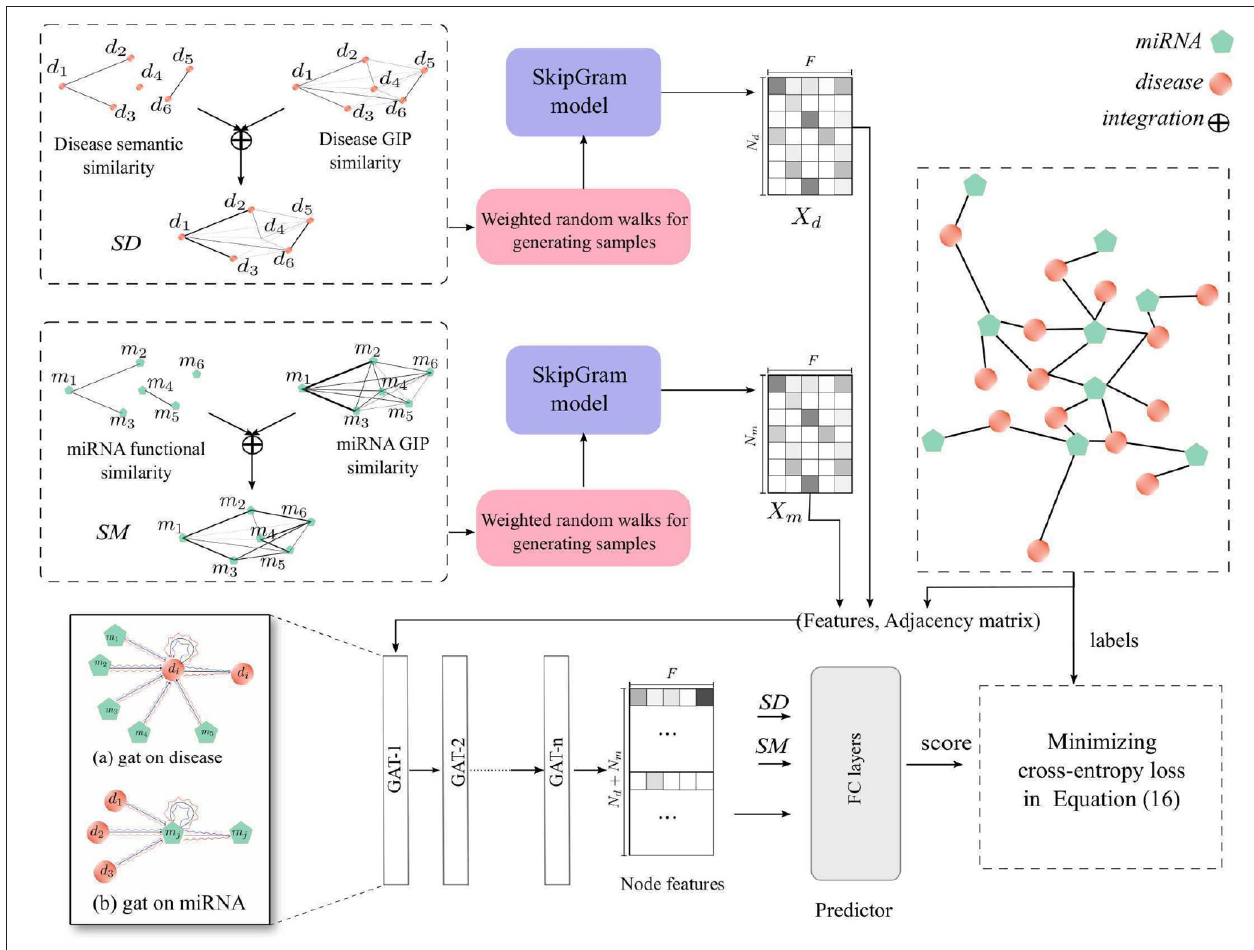
FIGURE 1 | The workflow of HGATMDA for miRNA-disease association